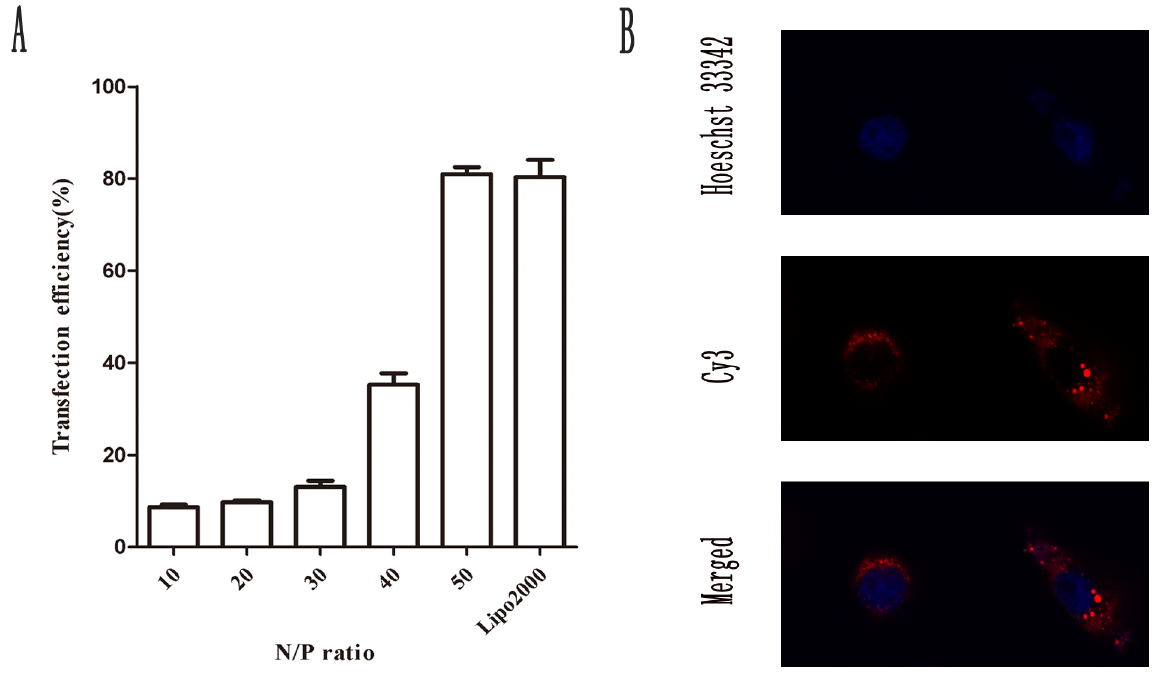
Figure 3. Transfection efficacy and cell uptake of siROCK2 complexes in U251 cells. A The ratio of Cy3-positive cells was detected by flow cytometry at various N/P ratios to analyze the transfection efficiency of siROCK2 complexes. The incubation time was 6 h. The concentration of siROCK2 was 100 nM. Lipo2000 was used as the positive control. B Representative LSCM images of U251 cells incubated with siROCK2 complexes at an N/P ratio of 50. The incubation time was 6 h. The concentration of siROCK2 was 100 nM. The nuclei were stained blue with Hoechst 33342, and the red fluorescence denotes Cy3-labeled siROCK2. The data are shown as the means 6 SD; n=3.